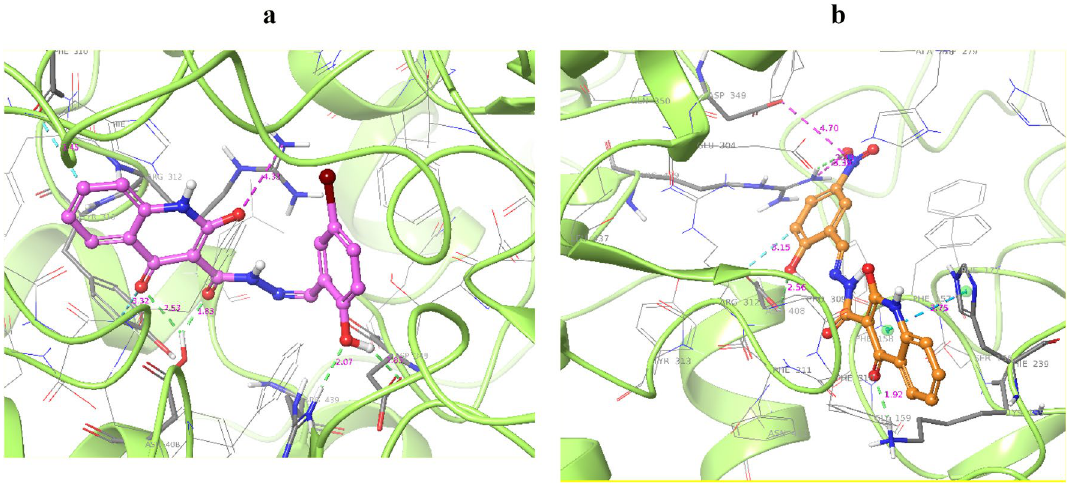
Figure 5. The pose and interaction pattern of 6l ( a ) and 6m ( b ) in the α-glucosidase enzyme.